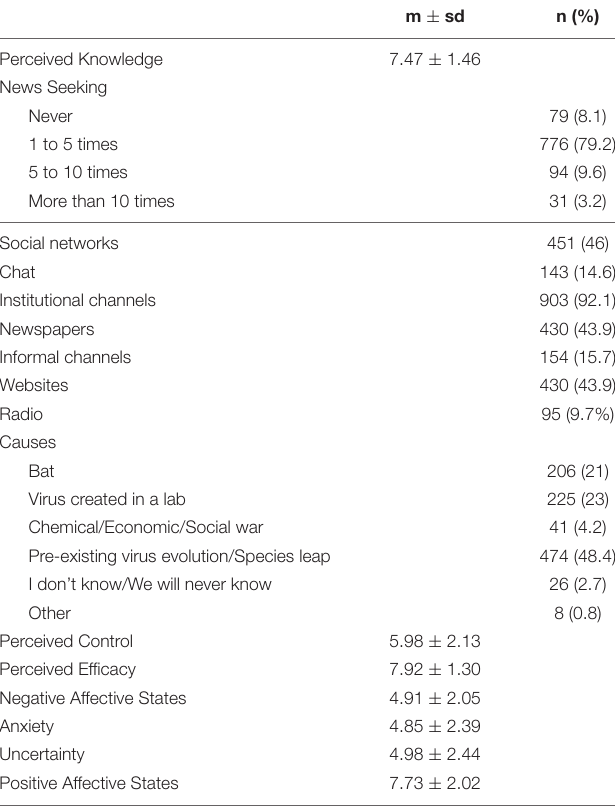
TABLE 2 | Descriptive statistics for risk-related